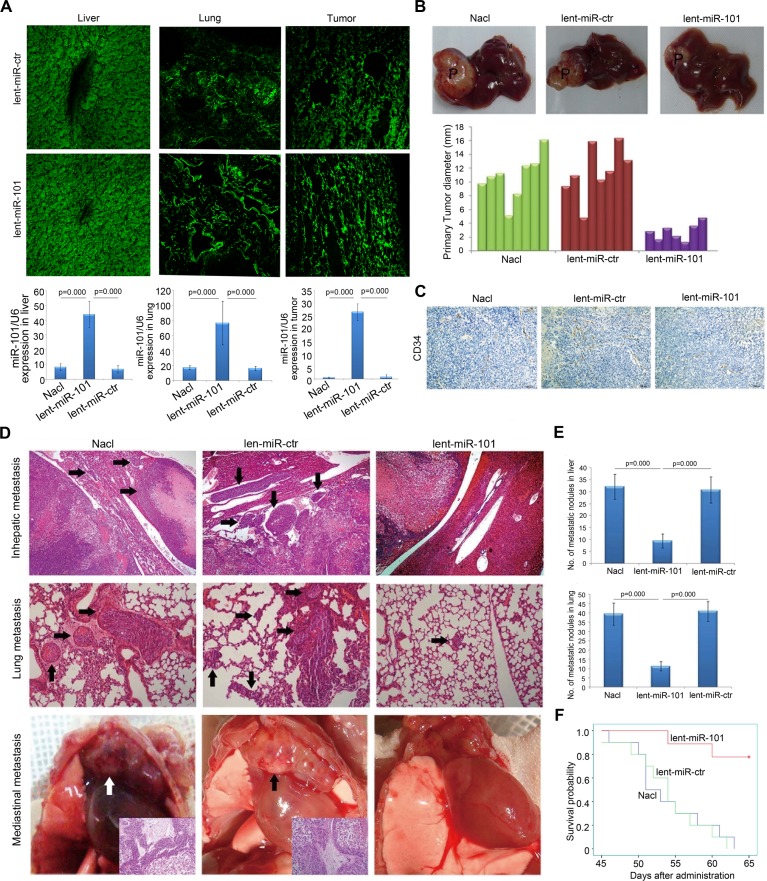
Systemic delivery of lent-miR-101 suppresses tumor growth, angiogenesis and metastasis in the orthotopic liver implanted HCC model of mouse.
A. Upper panel, laser confocal microscopy showed efficient infection of lentivirus to the liver, the lung and tumor xenografts of mice, as indicated by coGFP expression. Down panel, the levels of miR-101 in the liver, the lung and tumor tissues were significantly higher in lent-miR-101 treated mice than that in both control mice (P<0.001). Data is presented as mean± SE. B. Representative tumor xenografts in the liver of mice in different (NaCl, lent-miR-ctr and lent-miR-101) treated groups. P, primary tumor; M, metastatic nodule. The average size of primary tumors in the liver was 10.75±3.25 mm in diameter in NaCl treated group (n = 8), 11.51±3.71 mm in lent-miR-ctr treated group (n = 8), and 2.78±1.25 mm in lent-miR-101 treated group (n = 7). C. Representative images of microvessel density (MVD) of implanted primary tumor examined by IHC staining of CD34 in lent-miR-101 treated and 2 control groups. D. Representative images of metastatic nodules in the liver, in the lung and in the mediastinum of mice in different treatment groups (indicated by arrows). E. The mean number of metastasis in lenti-miR-101 treated group (liver: 9.4±2.9; lung: 11.3±2.5, n = 7) was significantly larger than that in control NaCl (liver: 32.1±5.1; lung: 39.4±6.0, n = 8) and lent-miR-ctr (liver: 30.8±5.4; lung: 40.9±5.4, n = 8) treated groups (P<0.01). Data is presented as mean± SE. F. The difference in survival time of mice between the lenti-miR-101 group and 2 control (NaCl and lent-miR-ctr) groups was statistically significant (P<0.05).